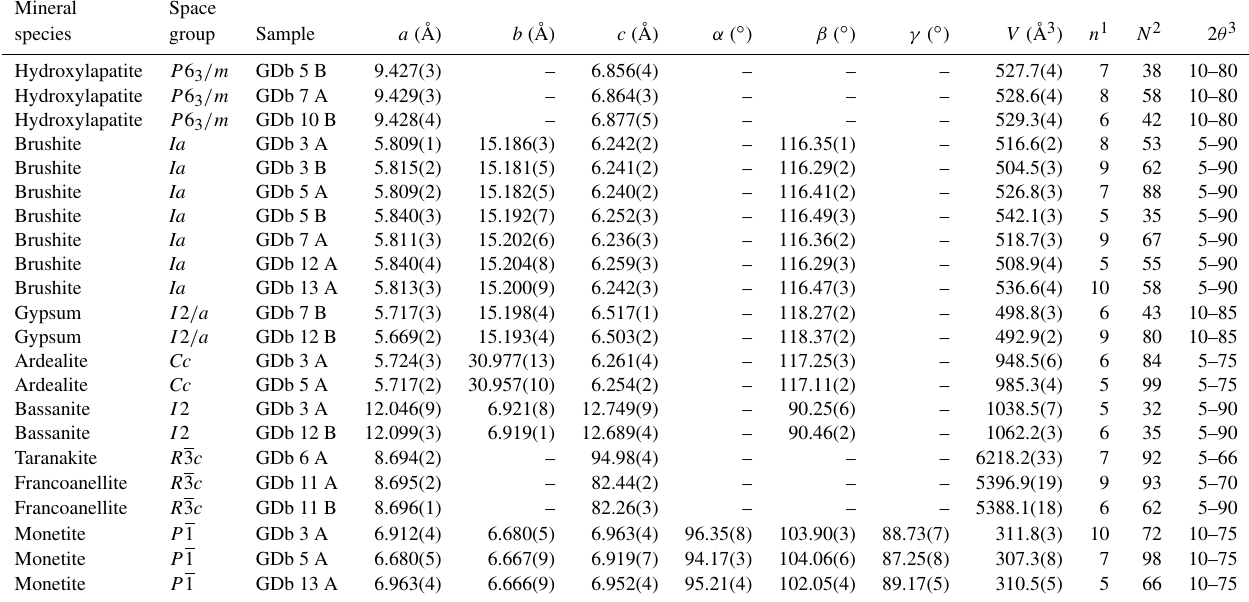
Table 1. Crystallographic parameters of selected guano minerals in the Gura Dobrogei Cave. Mineral Space